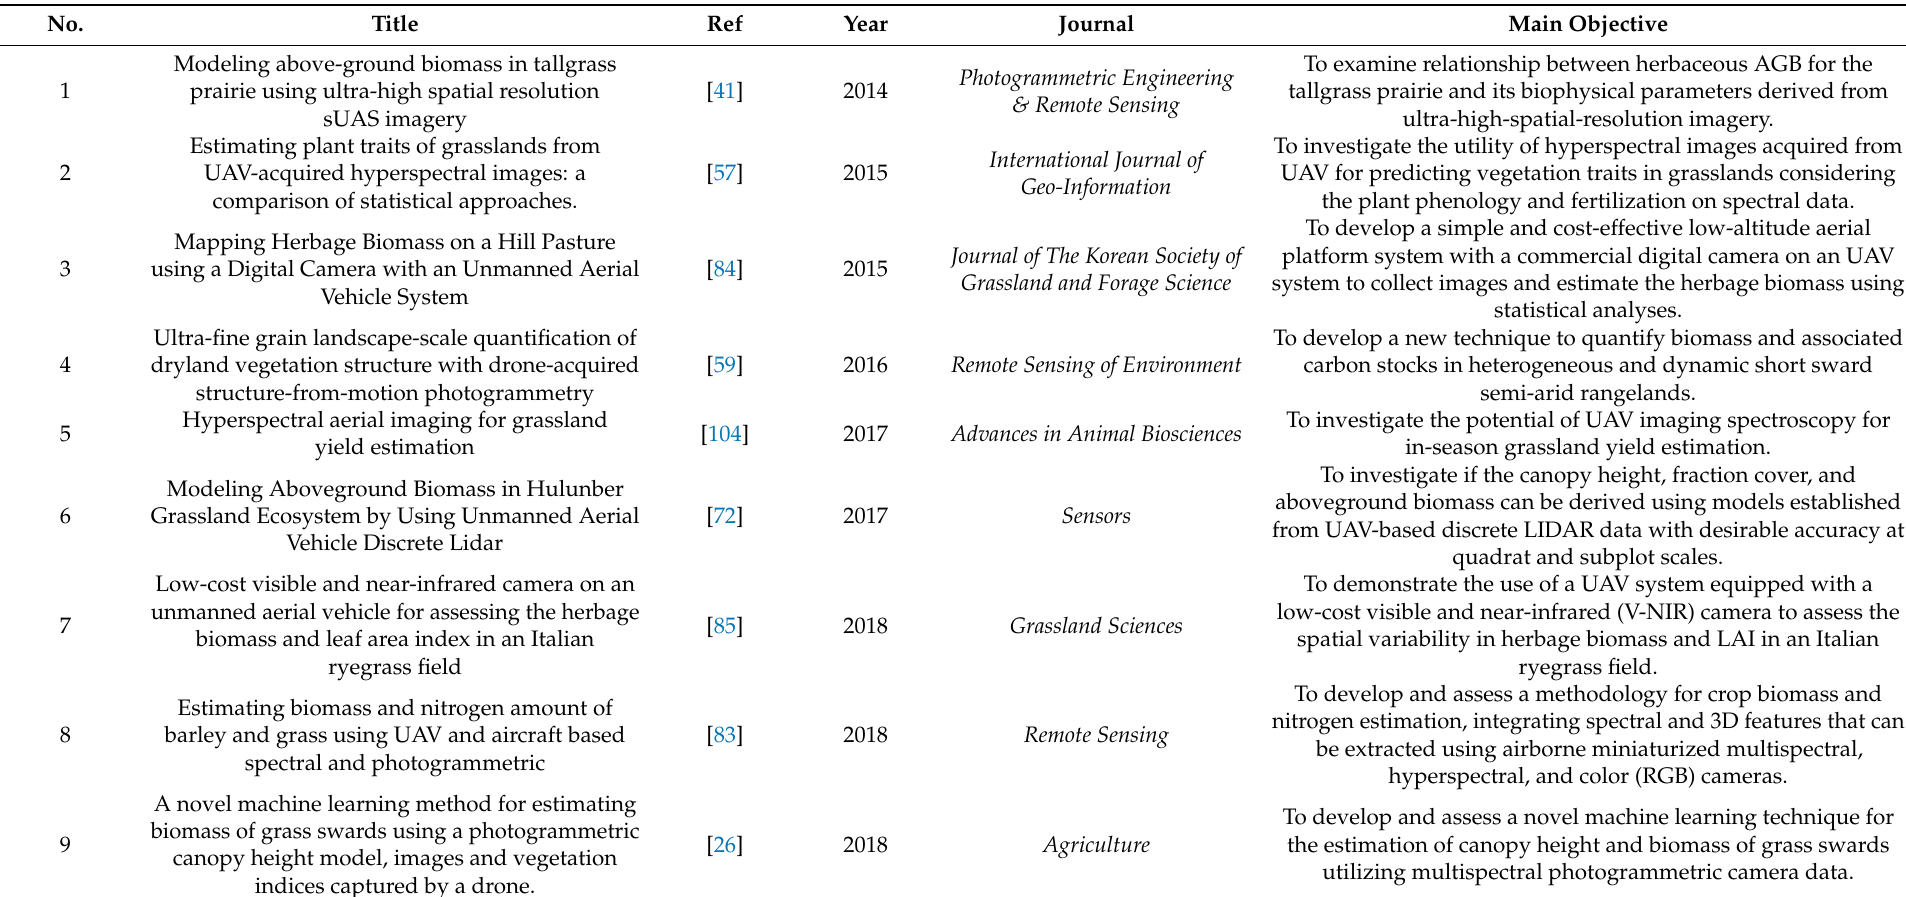
Table A1. Studies using UAV data to estimate grassland above ground biomass